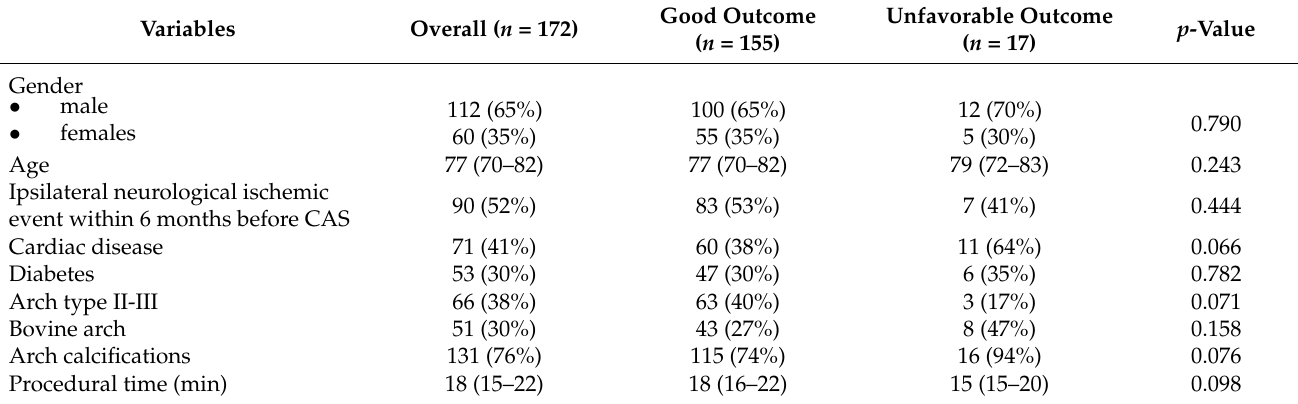
Figure 1. The diagram shows the patient enrollment flowchart. Abbreviations: CAS, carotid artery stenting; CTA, computed tomography angiography. Table 1. Main demographics, clinical, anatomical, and procedural carotid artery stenting